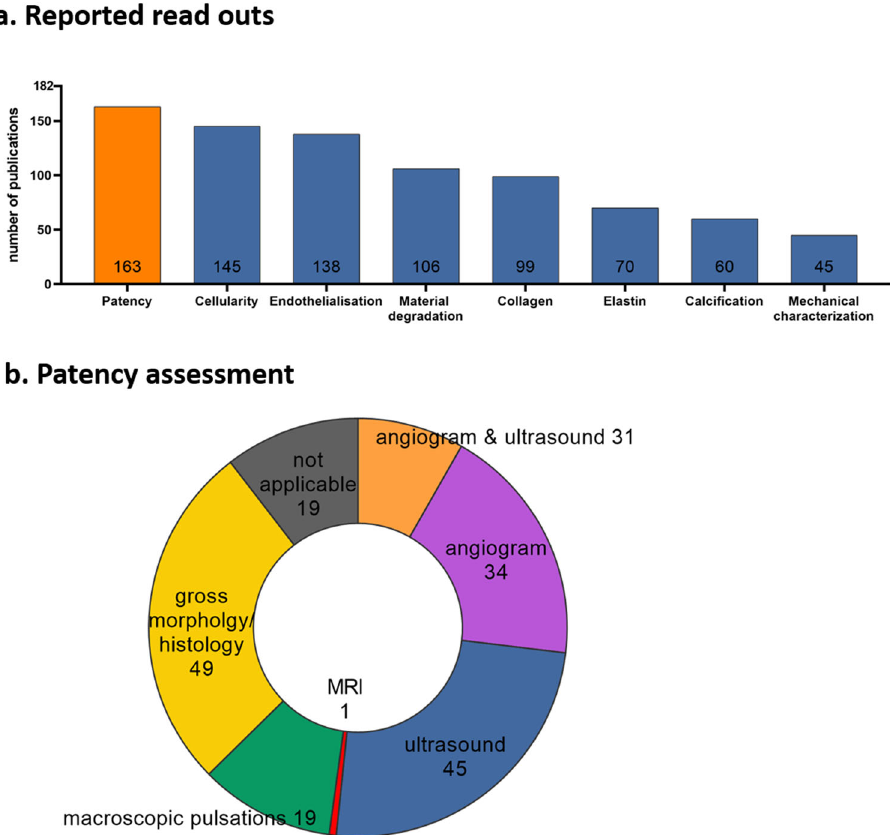
Fig. 7 Mapping of reported read-outs for preclinical TEVG assessment and patency assessment methods. a Number of studies reporting on read-outs; patency, cellularity, endothelialization, material degradation, collagen formation, elastin formation, calci fi cation, and mechanical characterization. b Number of studies per patency assessment method; combination of both angiogram and ultrasound, angiogram, ultrasound, magnetic resonance imaging (MRI), macroscopic observation for pulsations distal to graft upon explantation, gross morphology upon explantation and histology, or not applicable (number of studies not reporting on